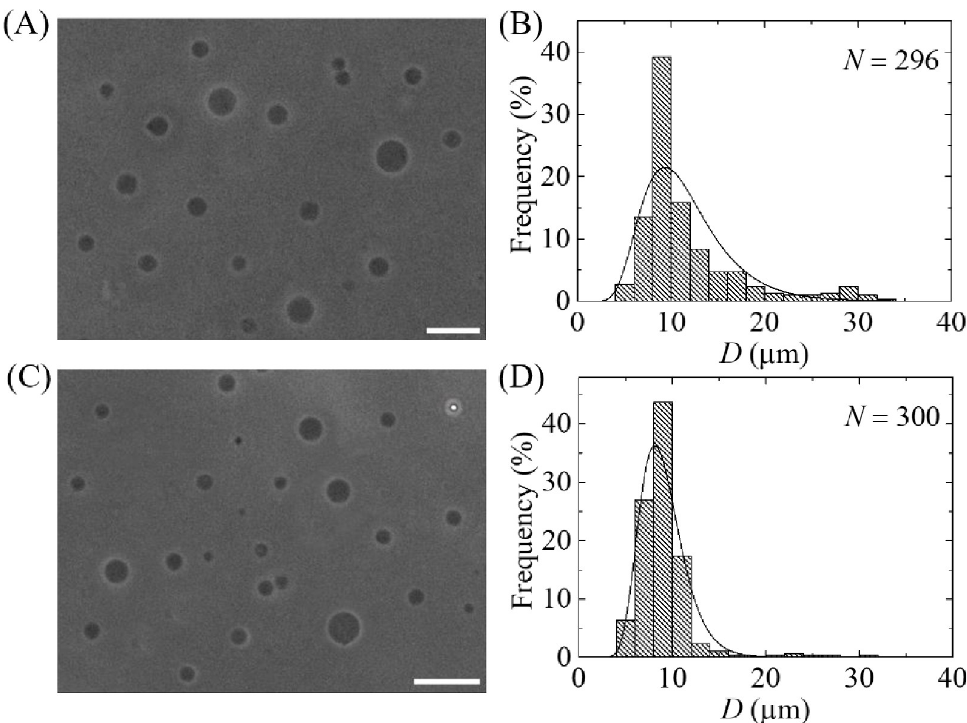
Fig 8. Effects of dual filtration with 12 and 8 μ m (case ii), and 10 and 8 μ m (case iii) pores polycarbonate membranes on the size and distribution of 40%DOPG/60%DOPC-GUVs. (A) and (B) show the phase contrast image and the corresponding size distribution histogram of GUVs in filter holder 2 for case (ii). (C) and (D) show the phase contrast image and the corresponding size distribution histogram of GUVs in filter holder 2 for case (iii). The purification was performed at flow rate 1 mL/min for 1 h. The bar in the images (A, C) corresponds to a length of 50 μ m. The solid line of B and D corresponds to fitting with Eq 1.